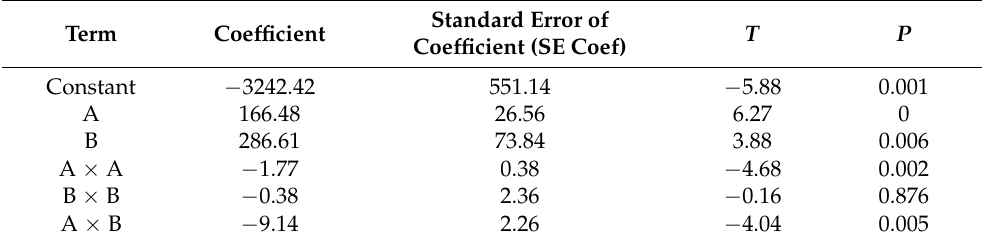
Table 6. Estimated regression coefficients of human TNF- α cell-free synthesis.